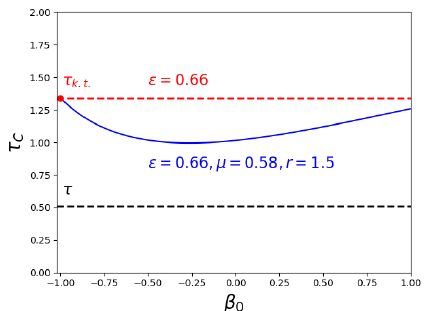
Figure 4. Attempting to reduce the di ff erence between τ and τ k . t . using Eq. 18 of Ref. [19]. The coe ffi cient of friction of two sliding MuMetall surfaces µ is measured in a lab test. r , the ratio of rotational and translational energy is assumed to be a constant depending on (cid:15) and µ during the cooling. Using Fig. 6 of Ref. [19], we estimate r to be